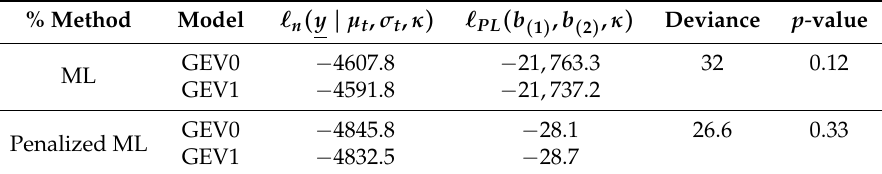
Table 2. Statistical comparison of the GEV0 model against the GEV1 model.